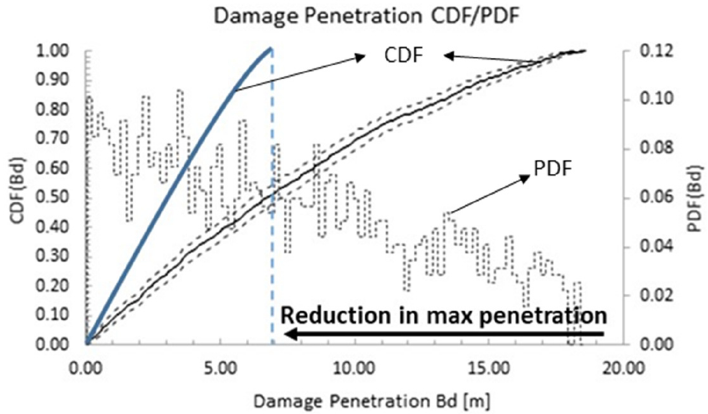
Figure 12 . Impact of a crashworthy ship’s structural section (blue line) on damage breach distribu- tion for a typical ship structure (black line). for a typical ship structure (black